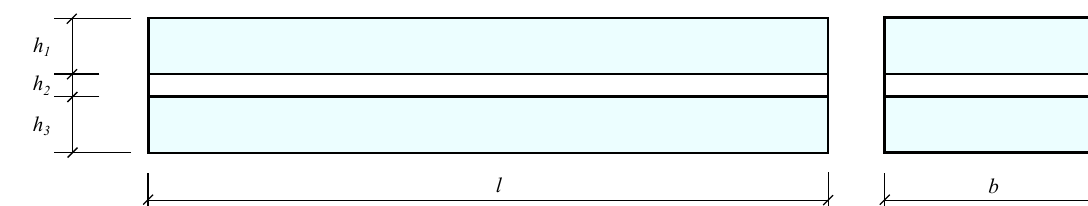
Figure 2. The layout of a three-layered laminated glass beam.